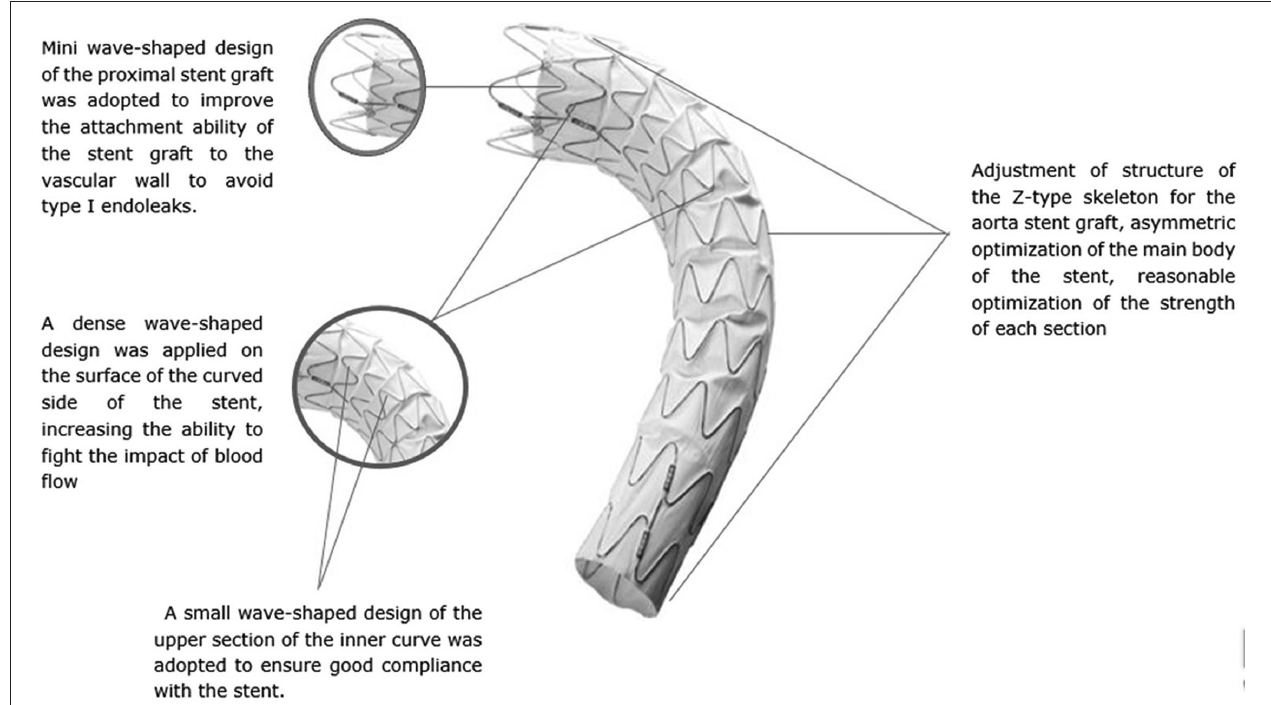
FIGURE 1 | Overall observation of the Ankura II stent